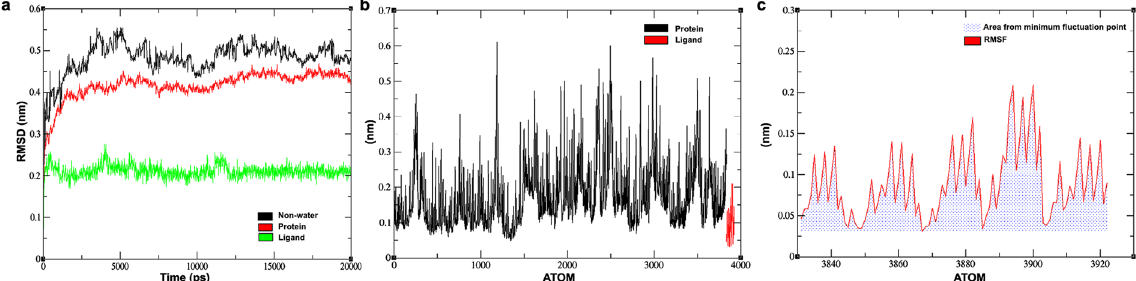
Figure 8. ( a ) RMSD plot of protein, ligand and complex ( b ), RMSF plot of protein and ligand ( c ), RMSF of minimized for 0.1 nanoseconds (ns) and for a maximum force greater than or equal to 10.0 kJ/mol. The produc- tion MD simulations were then carried out for 200 ns. The RMSD plot of the complete simulation indicates that the deviation from the initial structure continues to increase for the full simulation length. The deviation halted for short time intervals during the simulation but the plot direction faced upwards. The deviation was almost halted during 70 to 118 ns and then towards the end after 174 ns. The RMSF plot indicates that the initial region of the sequence has very less fluctuations whereas the later regions show higher fluctuations. Lower movement of helix and sheet region shows that loop regions provide flexibility to the protein structure. The residues that show maximum fluctuation are 210, 209, 212–215, 345, 344 and 256 respectively. The less-frequently fluctuated residues in the second half of the sequence indicate that these residues act as hinge points between the moving loop regions. The major hinge points in the sequence are residues 195, 221, 274, 310, 322, 332, and 361. The first half of the sequence showed lower fluctuations of around 0.1 nm to the minimum fluctuation. The area per atom plot indicates that the standard deviation of atoms in the second half of the protein was higher, in the first half of the sequence only a few atoms fluctuated more. The average accessible area plot showed that some residues were never accessible during the simulation at the same time some were less accessible and others were highly accessi- ble. The high number of peaks in the second half of the sequence shows that the loop regions interacted the most with other molecules whereas there were some residues in the first that also showed high accessibility. The average displacement that protein has faced during the simulation is plotted smoothly thus there is no strong structural activity detected during the simulation. The protein slowly and gradually changes its structural conformation in response to its surrounding. The secondary structure plot indicates that the number of residues in coils and bend regions decreases whereas the number of residues in turn and 3-helix regions increased. This change was not very prominent because only around 10–15 residues changed their state. Other structures did not show any significant change during simulation. The lack of major changes indicates that they are very stable and conserved. Plotting Hydrogen bonds between protein with itself and with other residues indicated a very stable hydrogen bond count during the simulation. There were higher numbers of hydrogen bonds between the protein residues than with non-protein residues. This indicated that the protein is more internally stabilized than from outside forces.